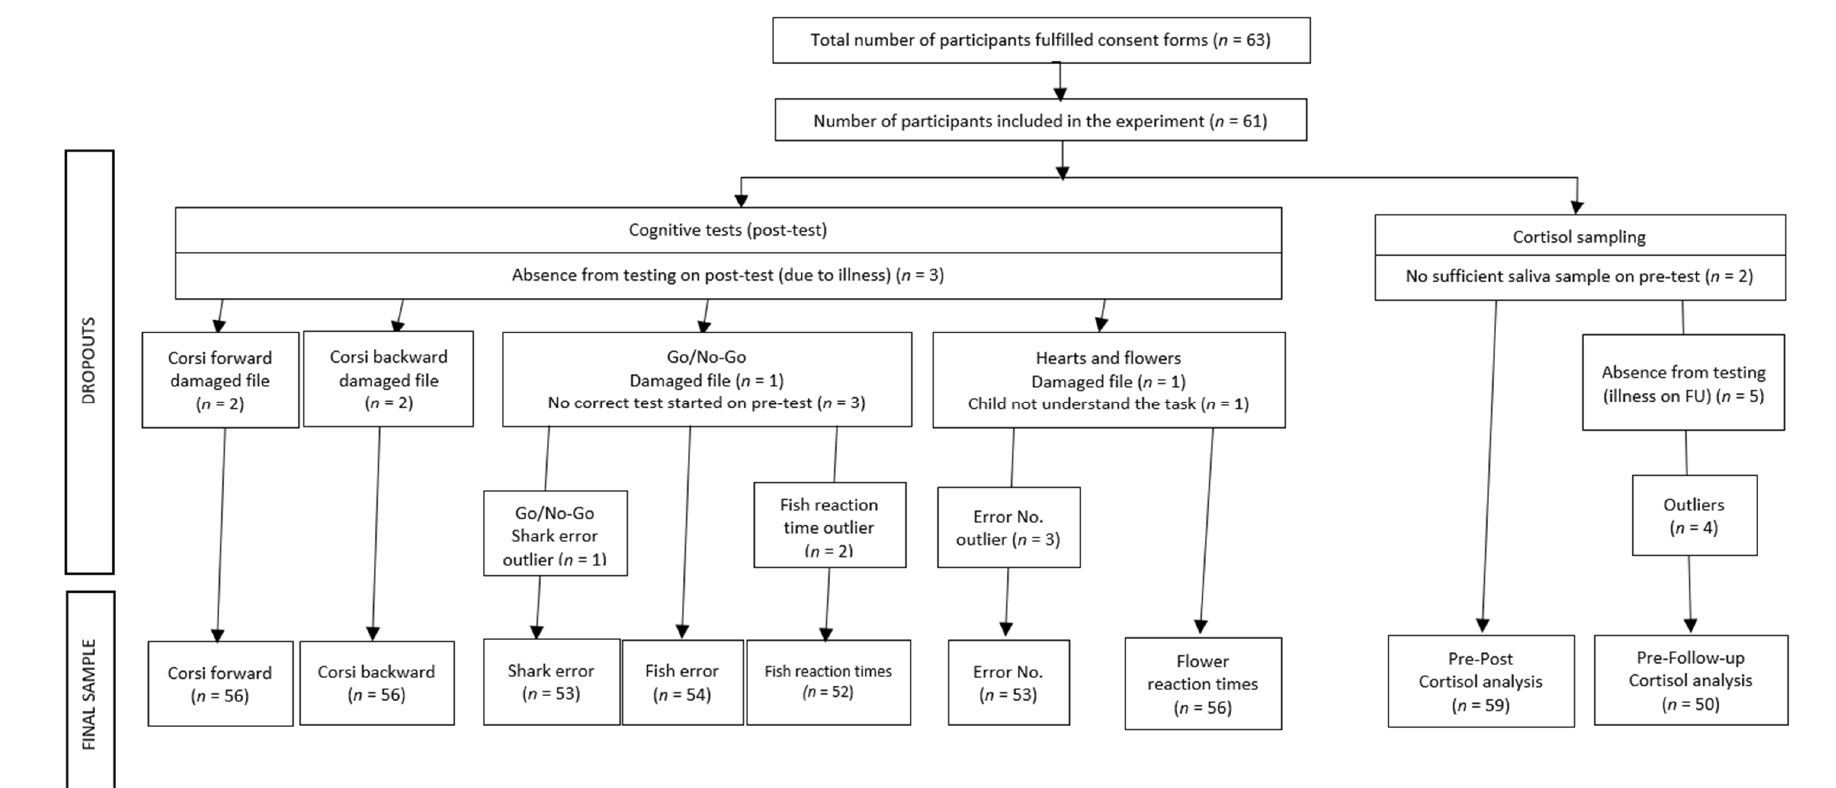
Figure 1. Number of participants whose data could be included in the final analyses.